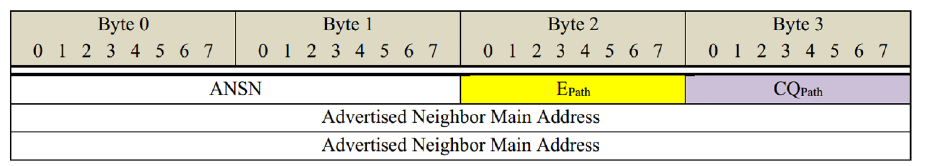
Figure 5. TC message format.